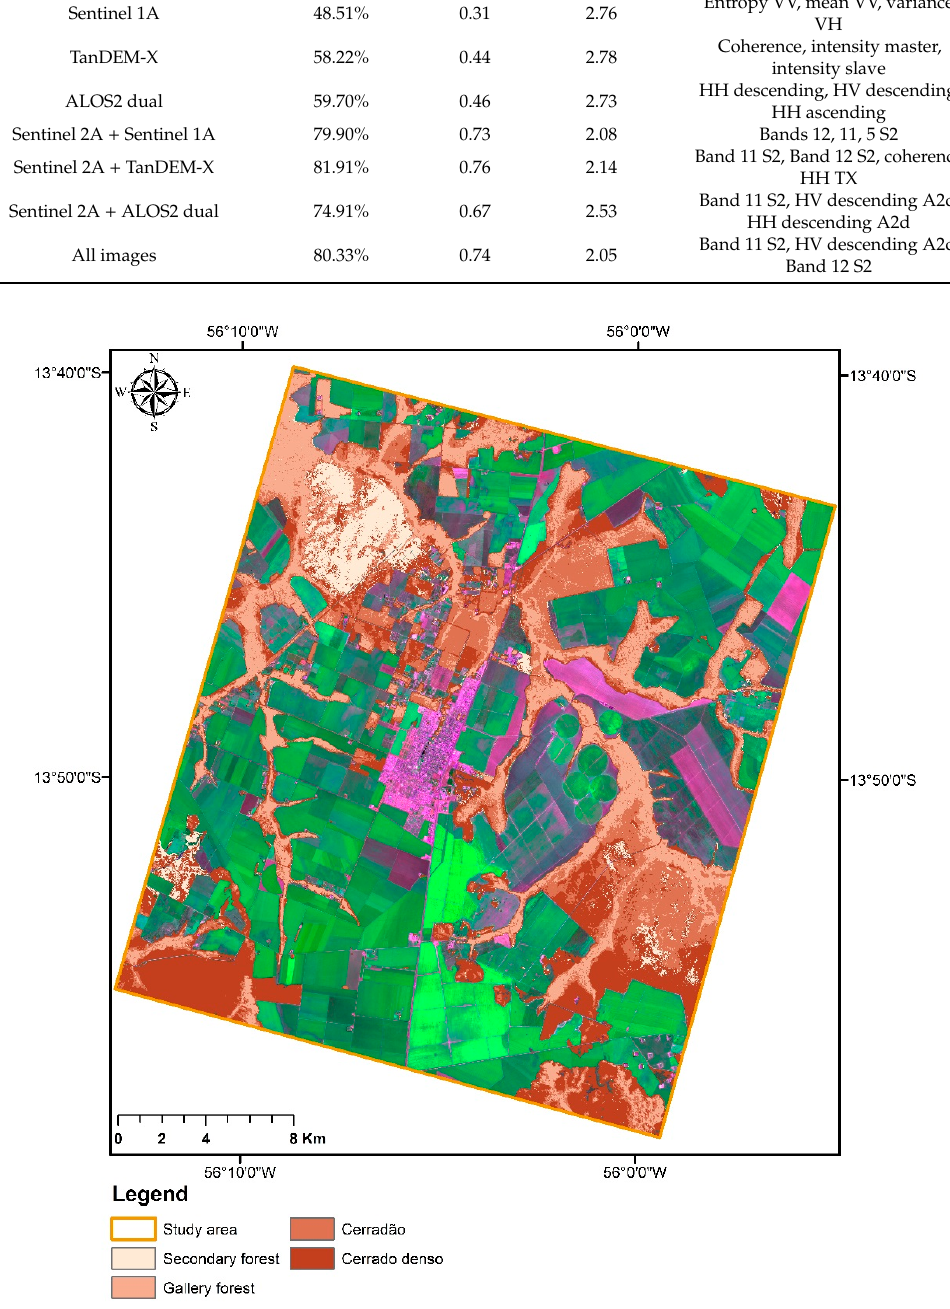
Figure 7. Classification results of the spatial distribution of the four Cerrado forest types using Sentinel 2A (dry season) on top of a false color composition of Sentinel 2A, Bands 3, 4, and 8 (07 July 2017).